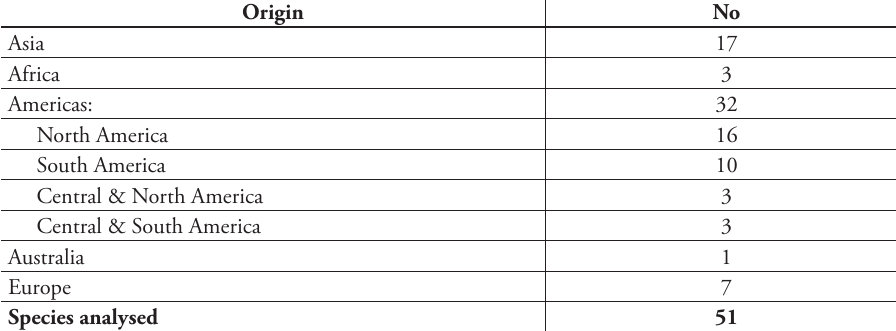
Table 2. The origin of the assessed species. Note that the total sum of species by regions of origin exceeds the 51 species analysed, because some of them have their origin in more than one